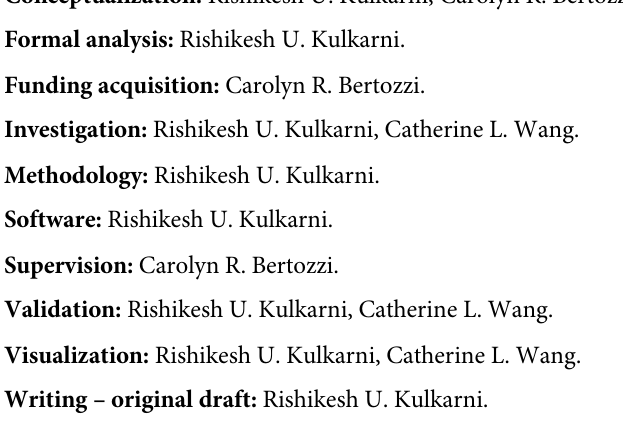
S1 Fig. Type I error rate for the hierarchical randomization test based on studentized covariance and the Wald test. S2 Fig. Type I error rate for the hierarchical randomization test based on studentized covariance and the Wald test given unequal between-cluster variance. S3 Fig. Type I error rate for the hierarchical randomization test based on studentized covariance and the Wald test given unequal